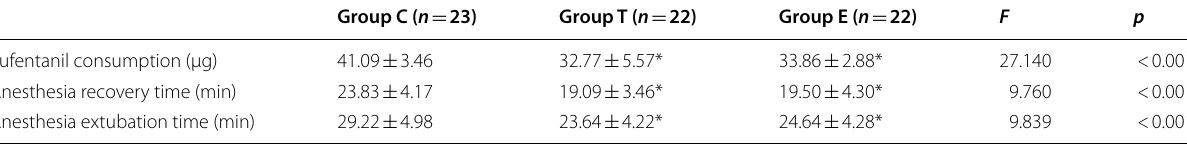
Table 2 Comparison of intraoperative sufentanil consumption, anesthesia recovery time and extubation time among the three groups ( x s ) ±